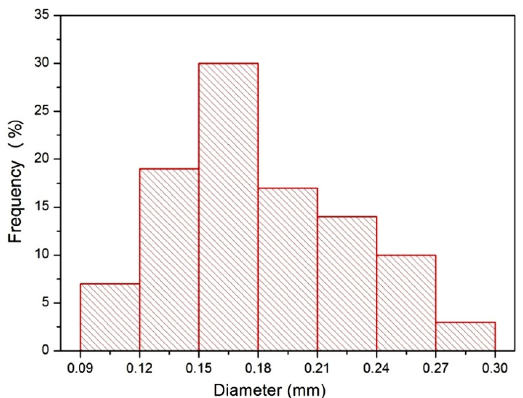
Figure 3. Typical load versus elongation curves of tensile tested fique fibers for each equivalent diameter interval. Source: